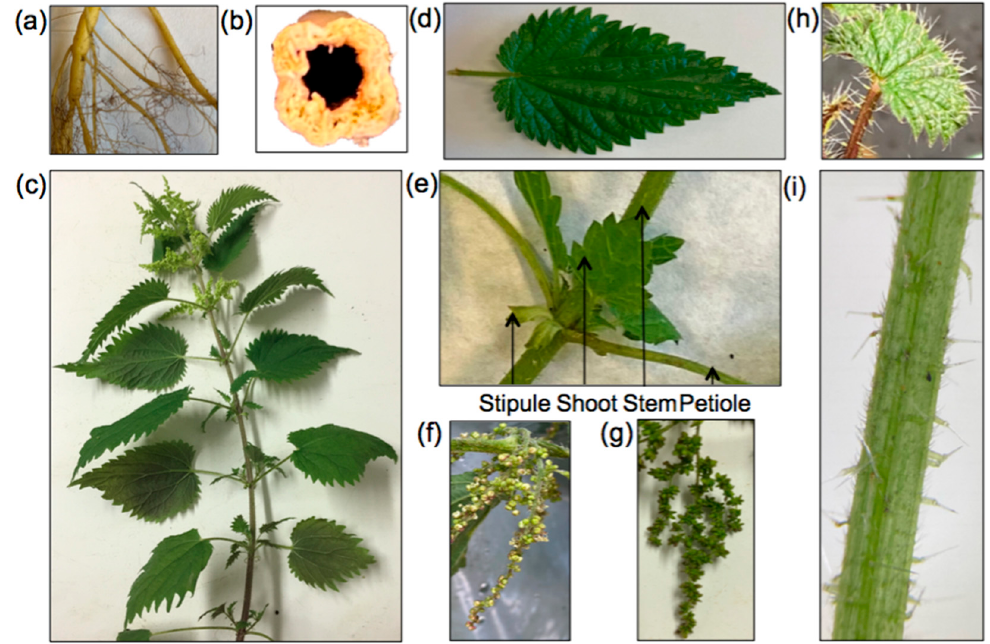
Figure 3. The morphology of the stinging nettle with focuses on ( a ) roots, ( b ) stem section, ( c ) shoots, ( d ) leaf, ( e ) node, ( f ) female and ( g ) male flowers, ( h ) leaf covered with stinging hairs, and ( i ) stinging hairs on the stem.